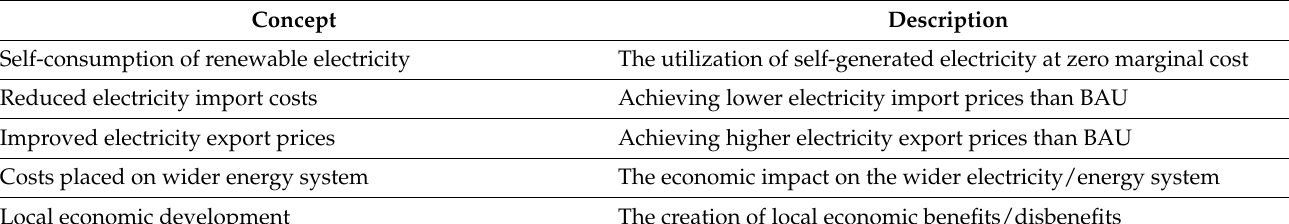
Table 4. Summary of economic value dynamics of P2P, CSC and TE models.